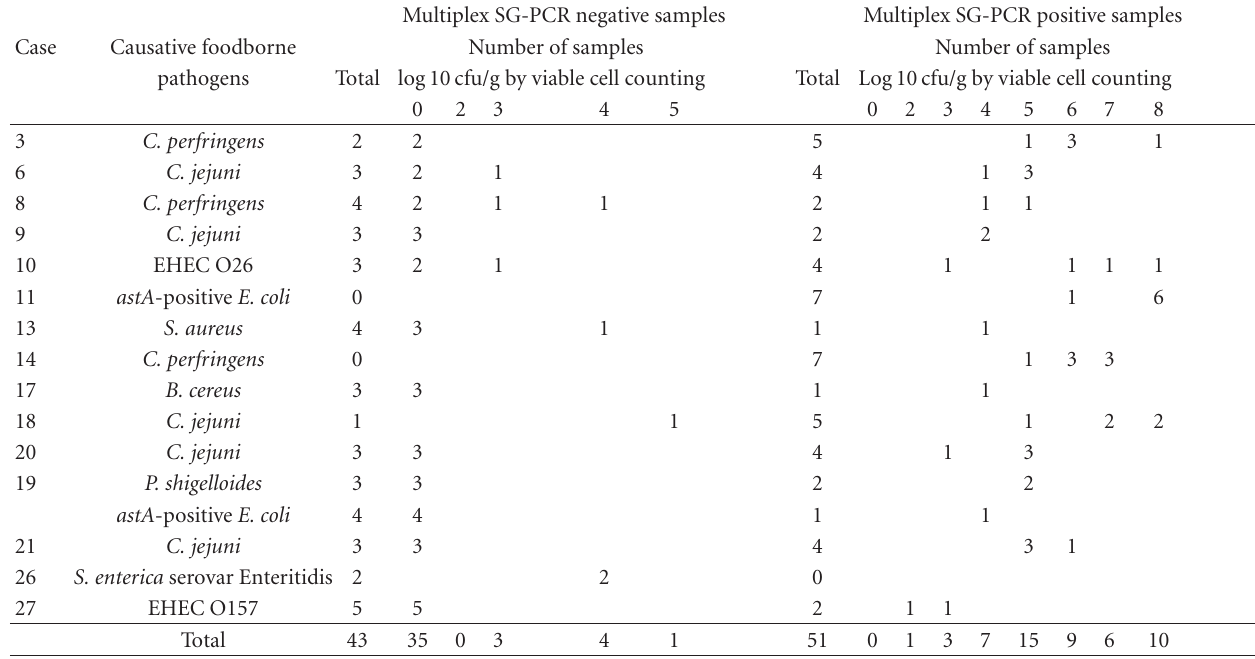
Table 4: The relationship between PCR detection and CFU in 15 foodborne outbreak cases by viable cell